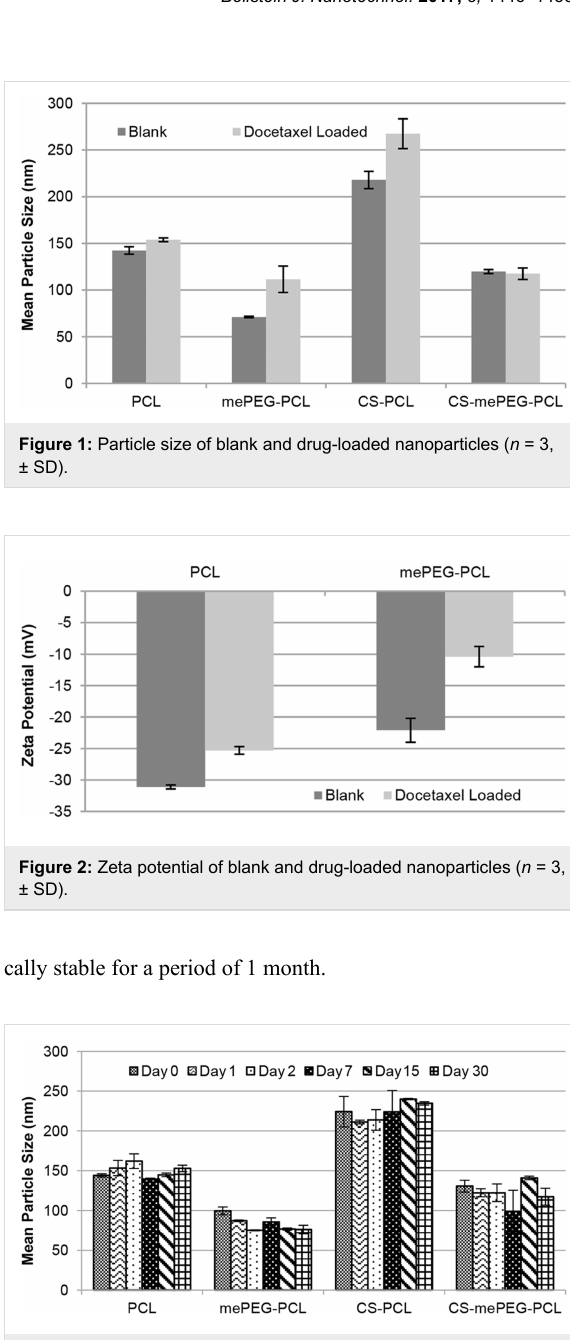
Figure 3: Mean particle diameter of nanoparticle formulations over the course of 30 days ( n = 3, ±